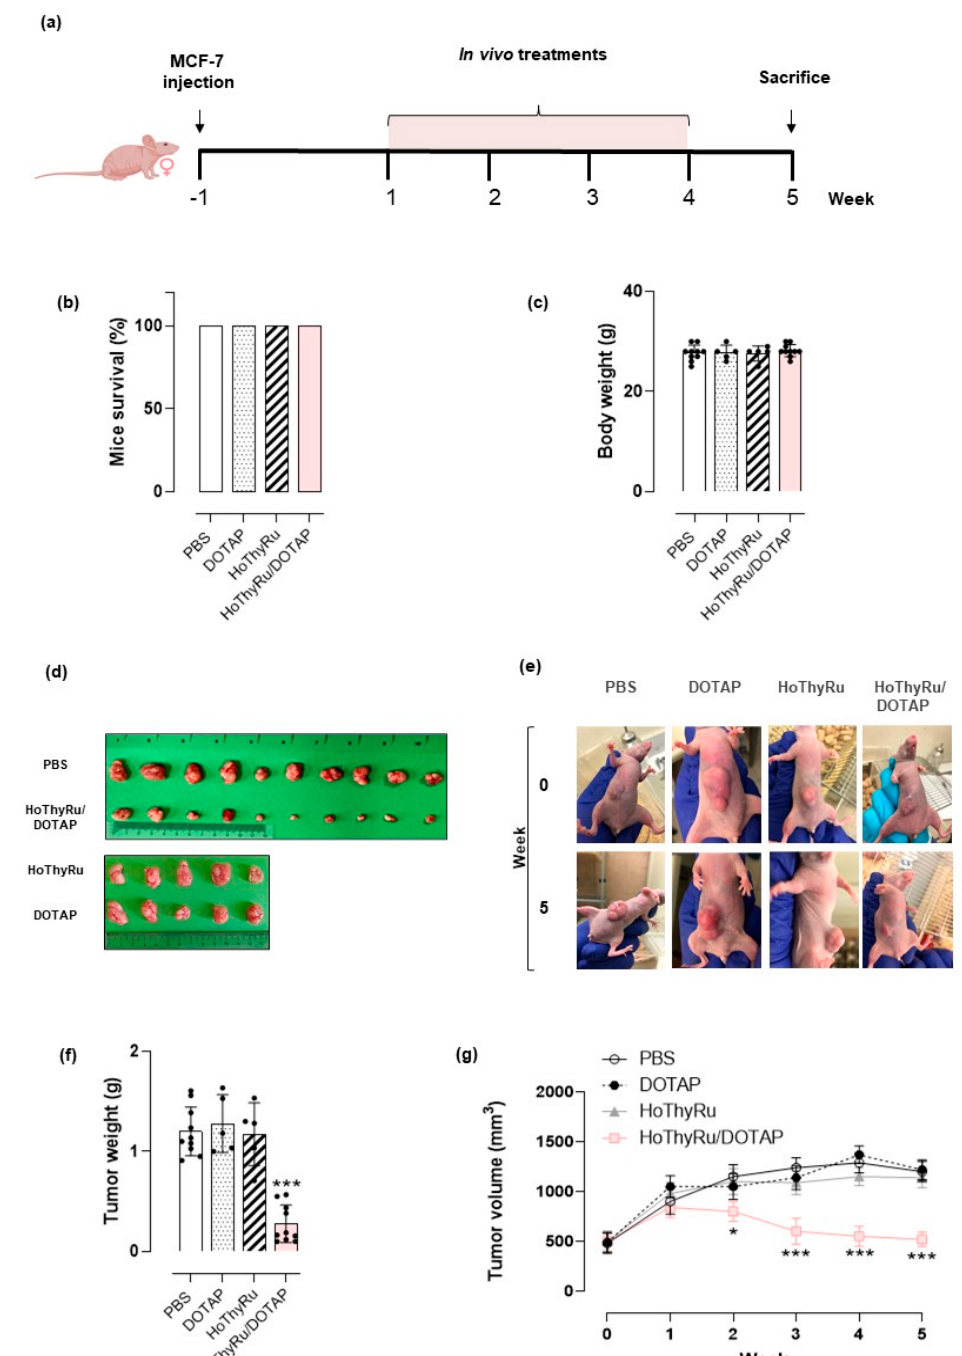
Figure 2. ( a ) Experimental protocol and therapeutic scheme based on intraperitoneal ( i.p. ) administrations of HoThyRu/DOTAP (15 mg/kg), once a week for 28 days. ( b ) Tumour-bearing mice survival and ( c ) body weights at the end of the study (5 weeks from the start of treatments). Control group: animal injected with PBS (Phosphate Buffered Saline pH 7.4, n = 10). Treated groups: animal injected with the DOTAP liposome (DOTAP, n = 5), the not co-aggregated HoThyRu complex (HoThyRu, n = 5), and the HoThyRu/DOTAP nanoformulation (HoThyRu/DOTAP, n = 10). ( d ) Explanted tumour masses at the end point of the study from untreated (PBS) and treated (DOTAP, HoThyRu, and HoThyRu/DOTAP) xenotransplanted animal groups. ( e ) Photographs taken at the end of the preclinical trial pertaining to treated (DOTAP, HoThyRu, HoThyRu/DOTAP) and untreated (PBS) xenotransplanted mice showing tumour inhibition by HoThyRu/DOTAP nanoformulation. ( f ) Weight analysis of the explanted tumour masses at the end of the study and ( g ) tumour volumes evaluation over time throughout experiments in mice control group (PBS, n = 10 animals) and in mice treated groups (DOTAP, n = 5 animals; HoThyRu, n = 5 animals; HoThyRu/DOTAP, n = 10 animals). Statistical analysis